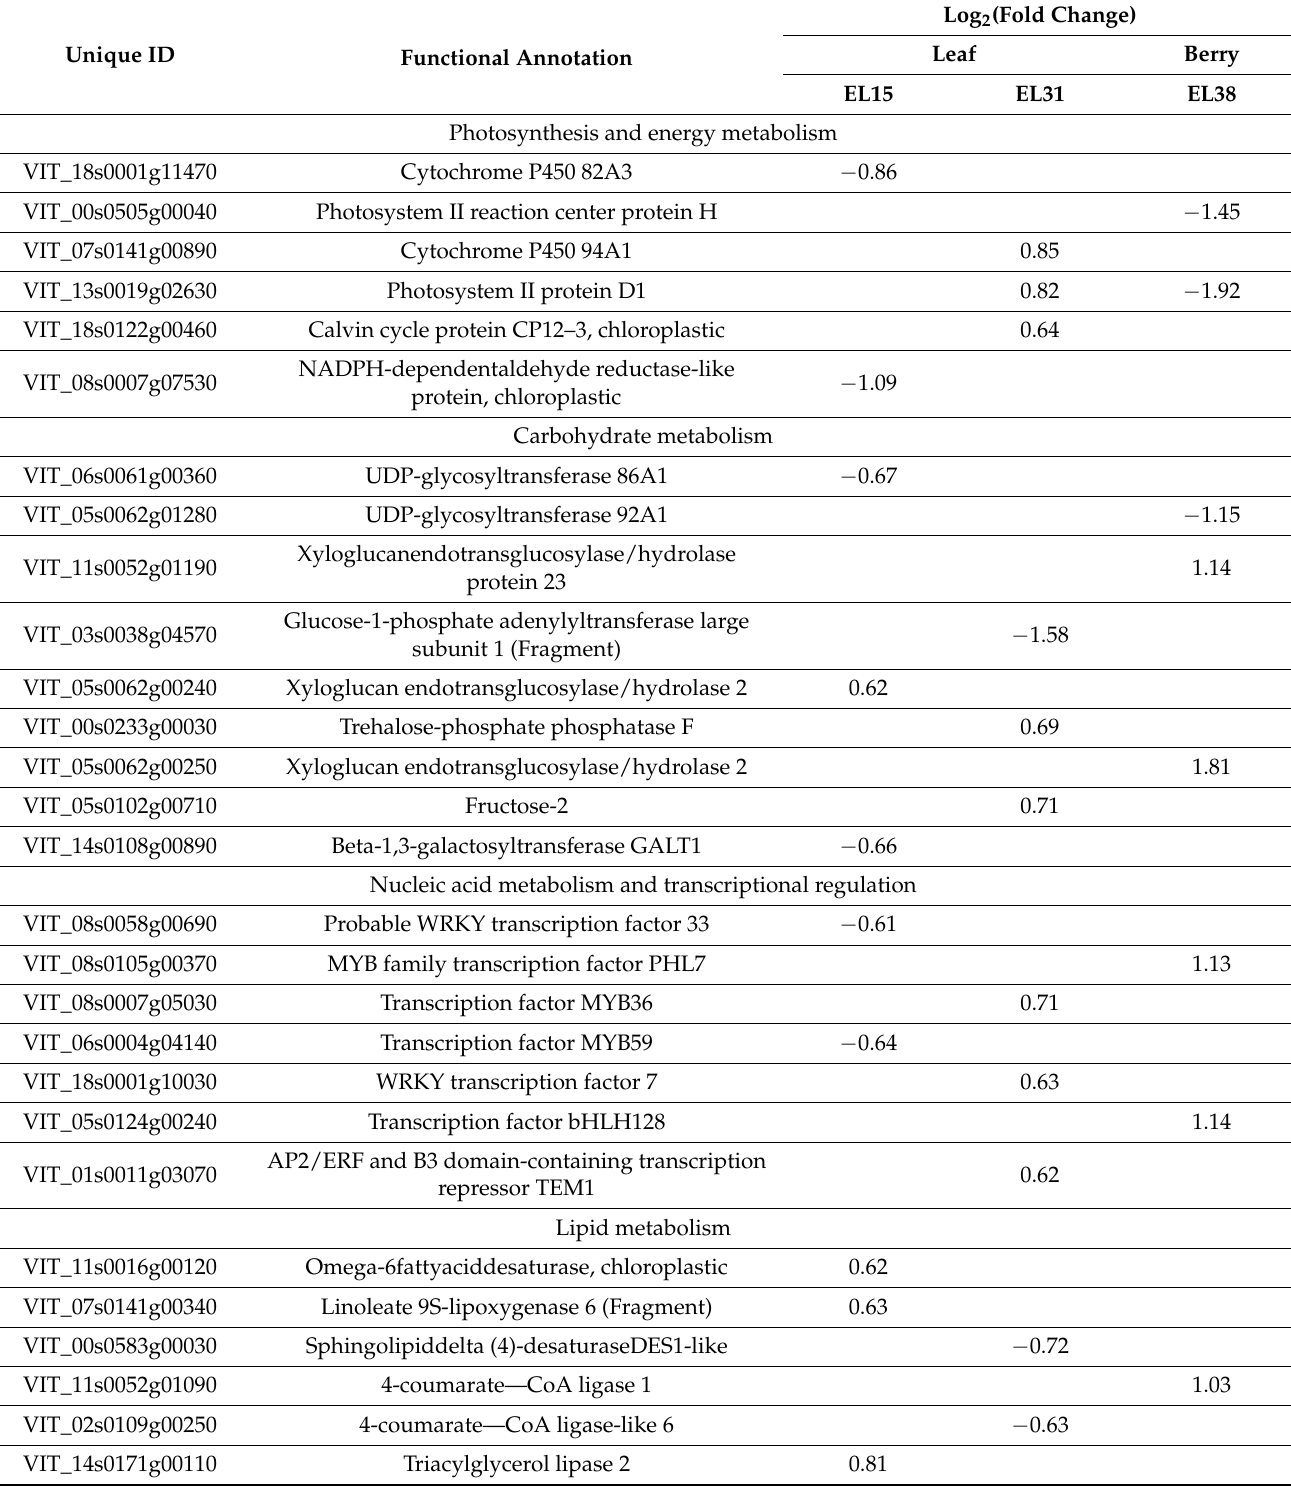
Table 2. Screening of genes significantly regulated in GFabV-infected and GFabV-free Leaves (at EL15, EL31) and Berries (EL38) in 2019 (considering a p value < 0.05 and log 2 (fold change) ≥ 1.5 or ≤